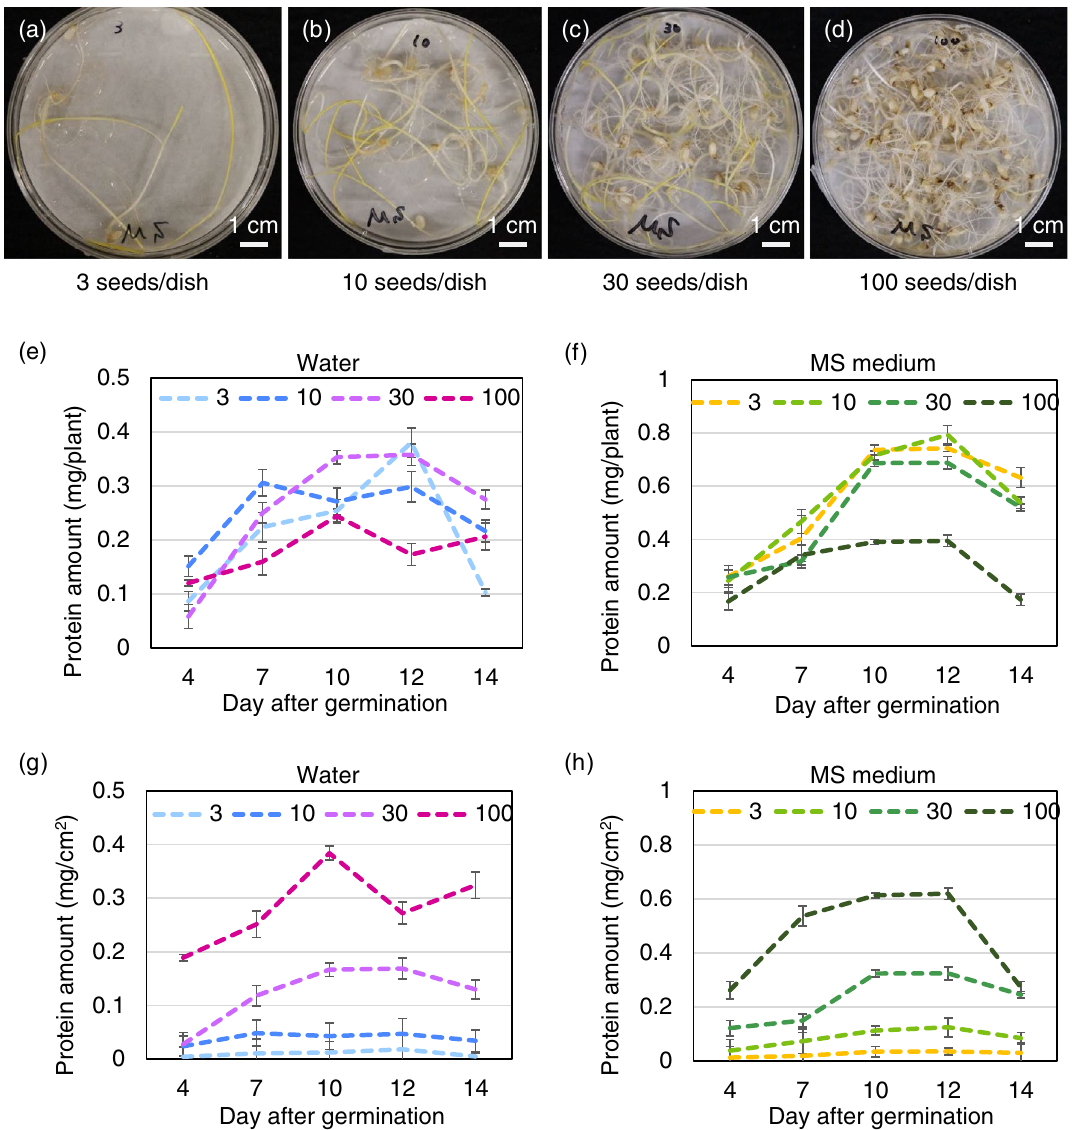
Figure 6. Effect of seedling density on the protein amount produced in rice seedlings. ( a - d ) Representative images of 3 ( a ), 10 ( b ), 30 ( c ), and 100 ( d ) rice seedlings at 14 DAG germinated and grown in a Petri dish in darkness and supplemented with MS medium. ( e – f ) Graphs show the total amount of soluble protein in each seedling (n = 5) germinated and grown in darkness with water ( e ) or supplemented with MS medium ( f ), and the protein amount per area in water ( g ) or MS medium ( h